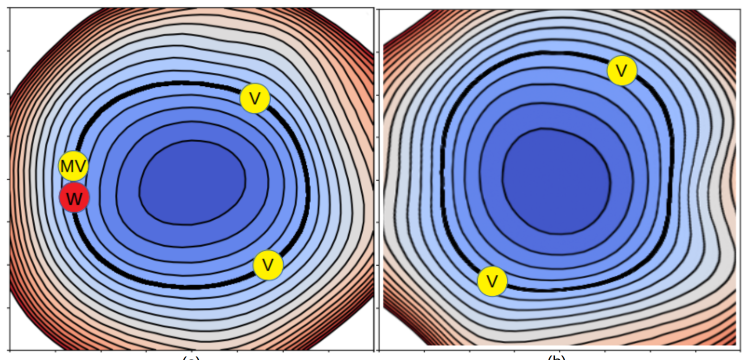
Figure 2. ( a ) 2D slice of a loss landscape with a W dot as the location of a given network. The V dots are two teleported versions of W inside the same landscape while the MV dot stands for a micro-teleportation of W. ( b ) The dots are teleported versions of W in a different loss landscape. Since neural teleportation preserves the network function, the six networks have the same loss value. In the case of ReLU, for example, the teleported networks with intra-landscape teleportation lie in the same